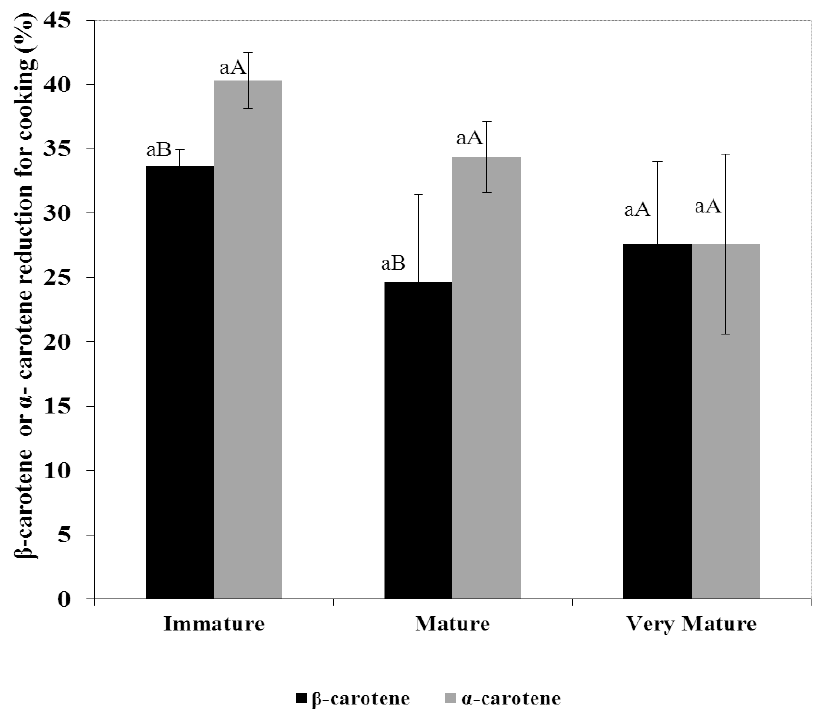
Figure 3. α-carotene and β-carotene reduction for cooking from winter squash pulp in three states of fruit maturity. Mean ± SEM ( n = 3). For α-carotene or β-carotene, different lowercase letters indicates differences between states of maturity (Tukey, p ≤